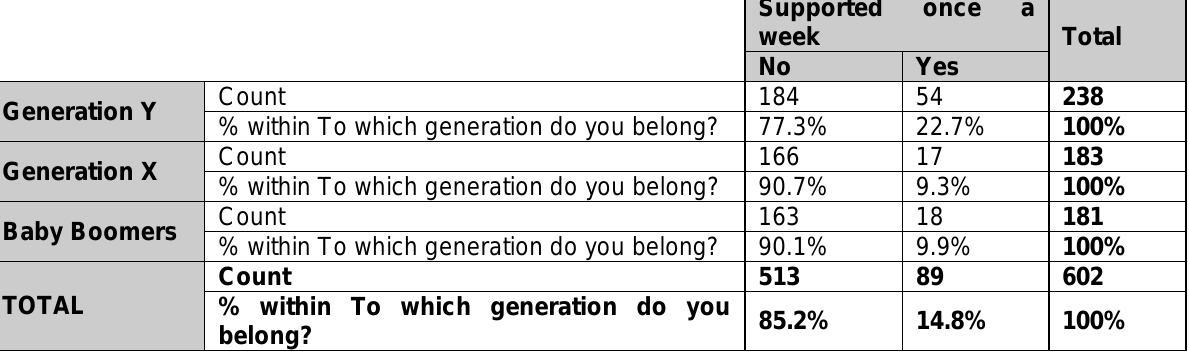
Table 6: Generations supporting NPOs once a week